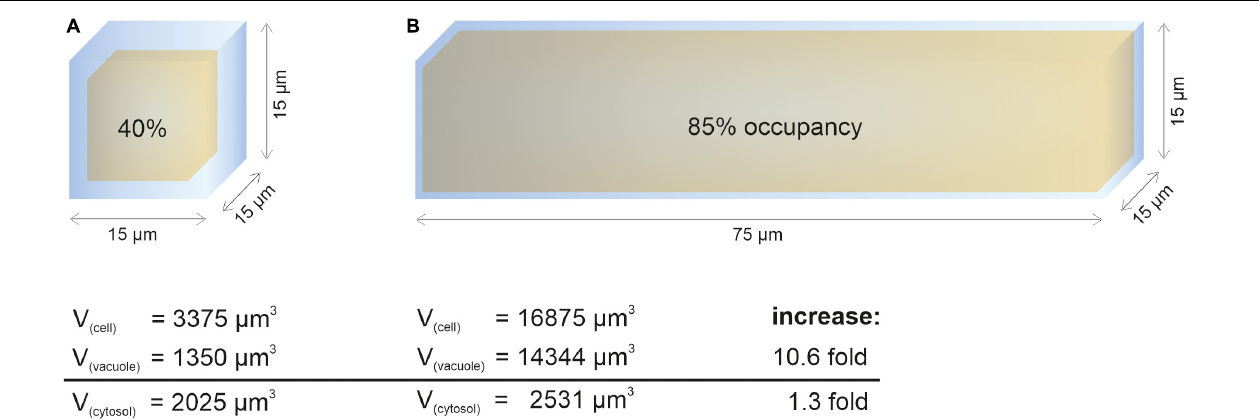
FIGURE 1 | Cytosol homeostasis during cell expansion. The cellular space occupied by the vacuole (occupancy) increases dramatically during elongation, allowing to keep the cytosolic volume relatively constant. For simplification, the geometric body of a cube was used to calculate vacuolar volume (yellow) and cell volume (blue). After subtraction, the remaining space was used to approximate cytosolic volume. Values for vacuolar occupancy were based on Dünser et al. (2019) in this figure. (A) Simplified epidermis cell of the late meristem from the Arabidopsis root with the edge length of 15 µ m. (B) Simplified 5-fold elongated cell from the transition zone. While the vacuolar volume increases more than 10-fold during elongation, the cytosolic volume only increases by factor 1.3.